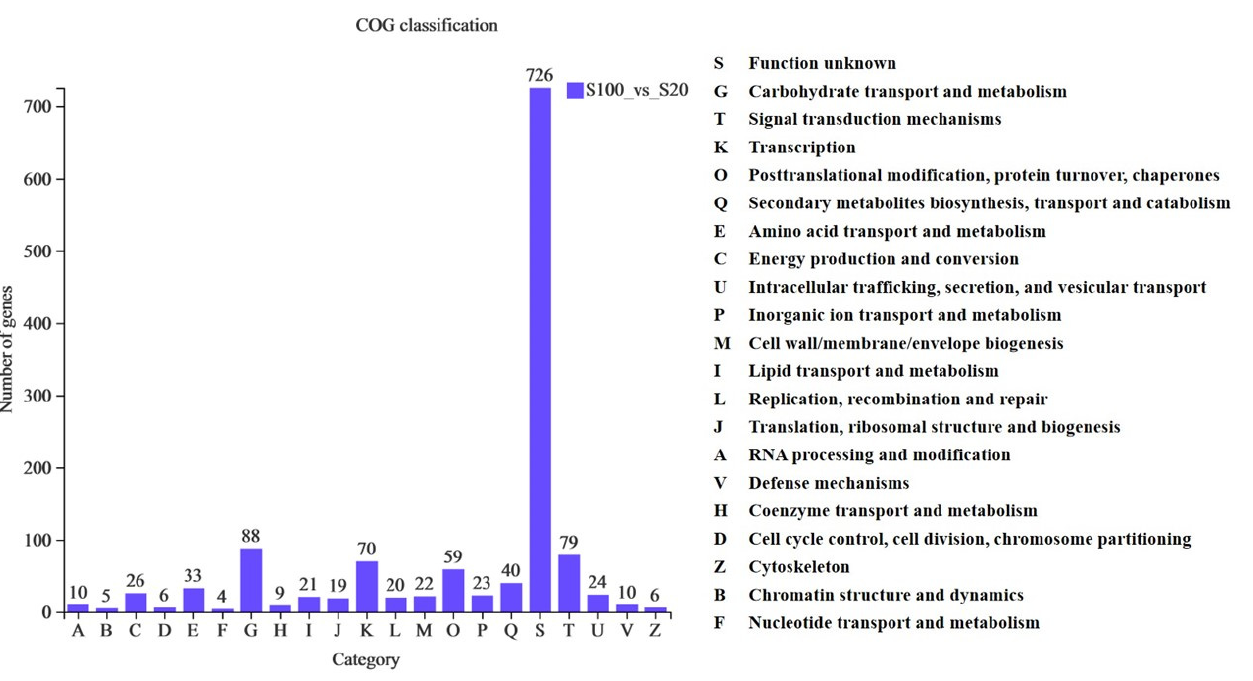
Figure 3. Histogram of COG classification statistics of differentially expressed genes. The abscissa represents the functional type of COG, and the ordinate represents the number of genes with this type of function.